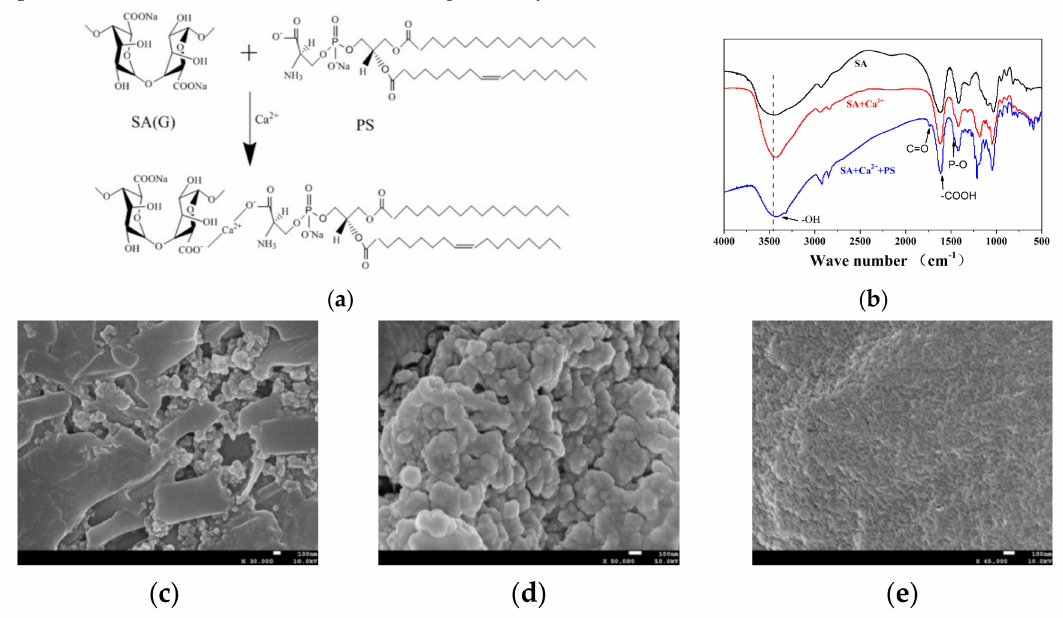
Figure 2. Schematic diagram of the bonding between the PS in thermo-responsive phospholipid microcapsules and the carboxyl groups in the alginate ( a ), FTIR spectra ( b ), SEM images of prepared by addition of microcapsules to sodium alginate (SA) ( c ), SEM images of TSPMAH by addition of SA to microcapsules ( d ), and SEM images of SA crosslinked with Ca 2 + ( e